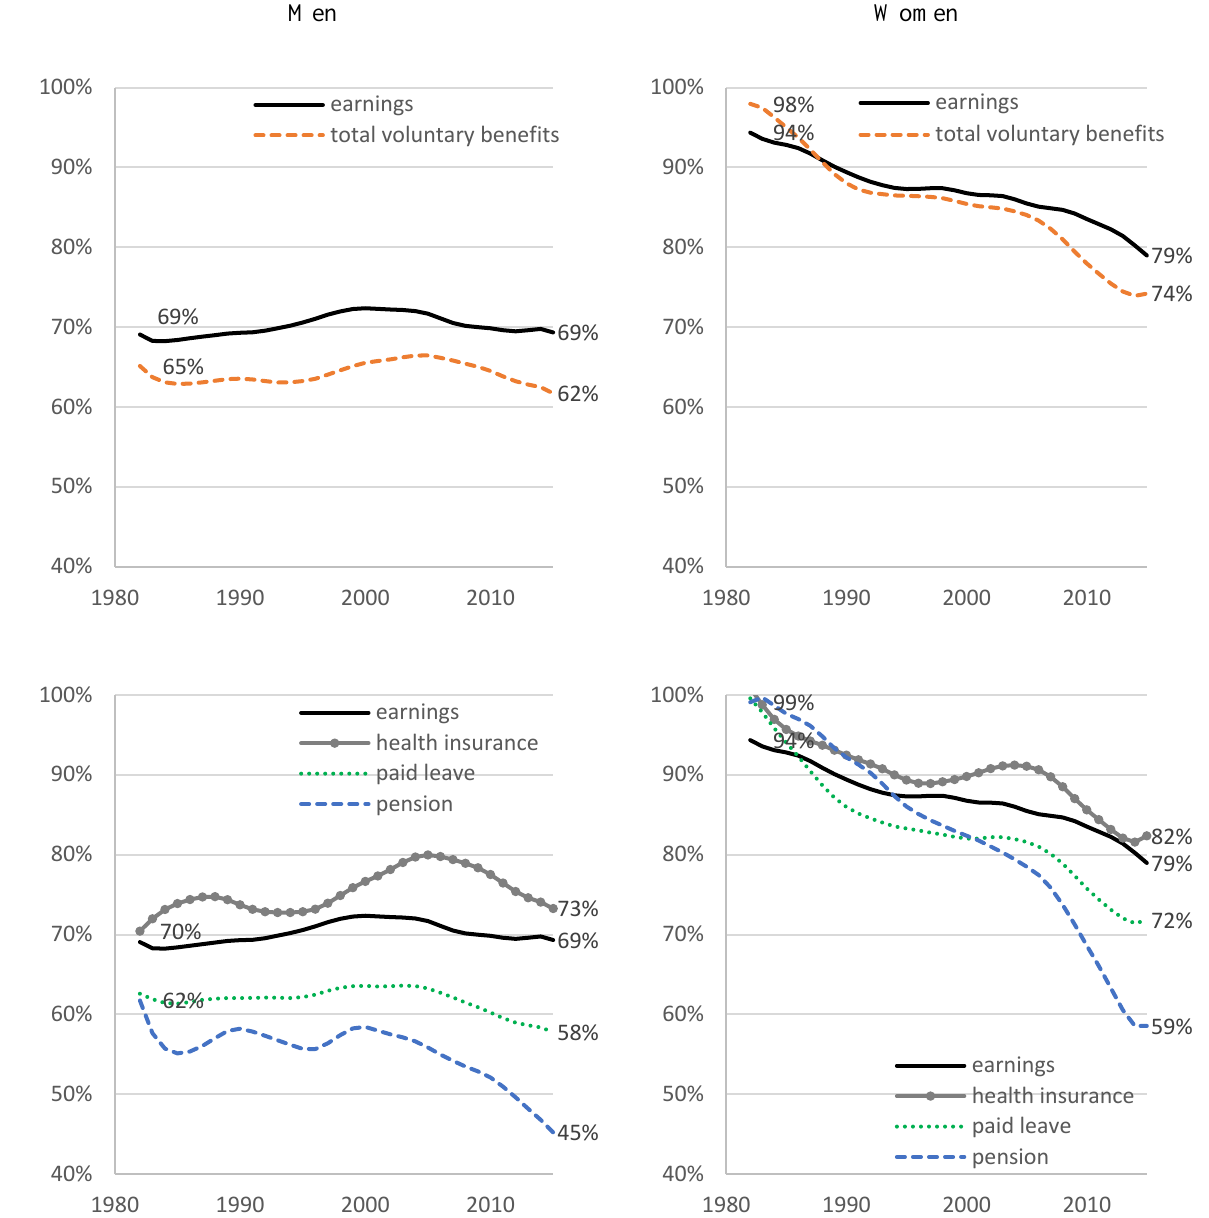
Figure 5: Black-to-white health insurance, pension, paid leave, and total voluntary benefits and earnings ratios (percentages), 1982–2015.